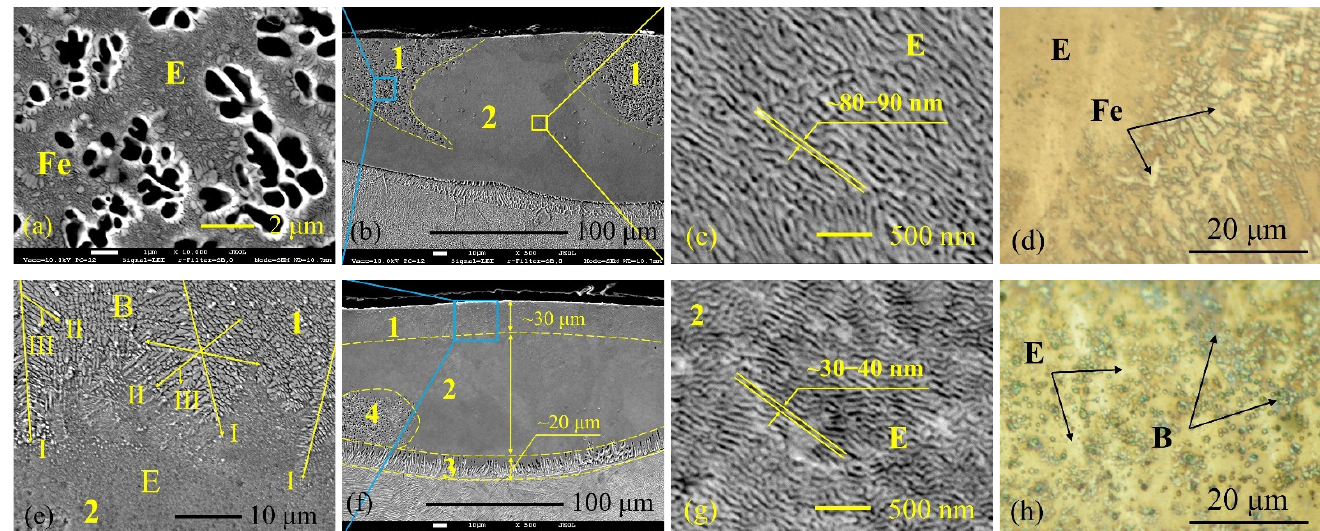
Figure 10. Near-eutectic microstructure of the layers laser-boronized at 1000 ( a – d ) and 1250 ( e – h ) mm/min laser operating speed; ( a ) area of hypoeutectic structure—Fe-based solid solution dendrites (Fe) surrounded by the boride shell, which separates them from eutectic phase; ( b ) a general view of the melt pool—mainly eutectic structure (2) with areas of hypoeutectic (1); ( c ) and ( g )—lamellar nanoeutectic structure under higher magnification; ( d ) and ( h )—optical micrographs of microstructure after coloring etching; ( e ) top of melt pool—boride dendrites (arrows show direction of primary (I), secondary (II) and third (III) dendrites’ arms); ( f ) general view of melt pool with denoted four zones; E—eutectic; Fe— γ Fe-based solid solution; B—boride; (3)—a layer with Fe-based solid solution dendrites; (4)—area of hypoeutectic